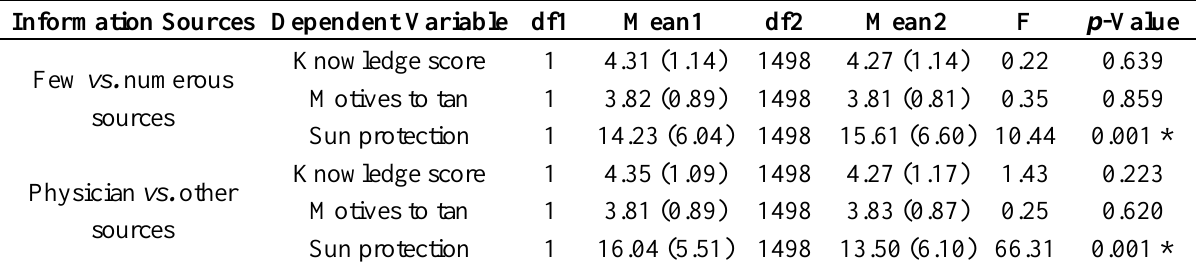
Table 3. Results from Anova for effects of information sources on skin health knowledge, motives to tan, and sun